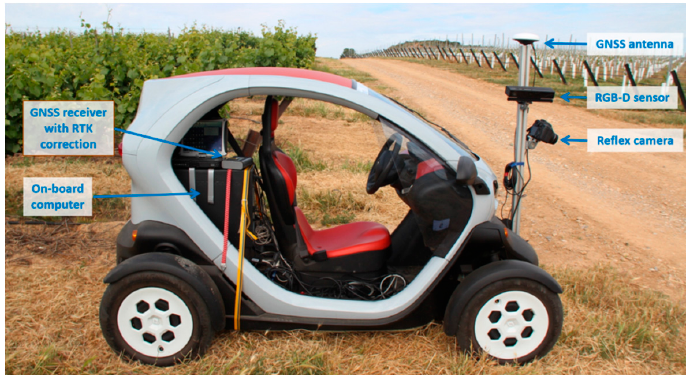
Figure 2. Electric platform equipped with an on-board computer for autonomous navigation and signal processing. The Kinect v2 sensor was installed on an adjustable height structure, provides RBG and distance information associated to Global Positioning System (GPS) coordinates.